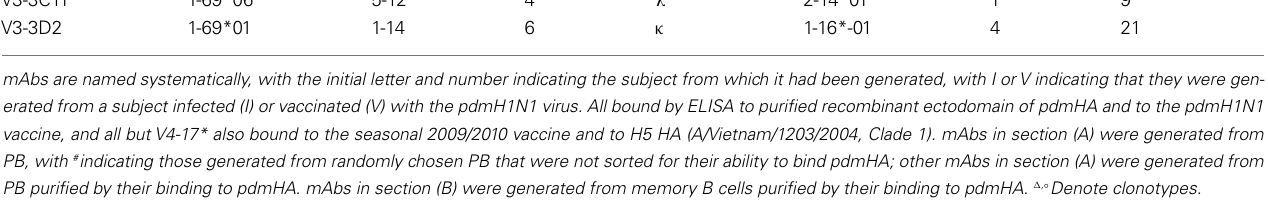
( Figure 3 ; Table 1 ) and all bound to the purified ectodomain of H5 HA of an H5N1 avian influenza virus A/Vietnam 1203/2004 (Clade 1; Table 1 ; Figure 3 ). The binding of the anti-HA stem mAbs to the seasonal influenza and pdmH1N1 vaccine was com- parable to the binding of the anti-HA head mAbs (e.g., binding of V2-36 to the seasonal influenza and pdmH1N1 vaccine and binding of V4-17 to the pdmH1N1 vaccine, Figure 3 ). Thus, the two conventionally manufactured vaccines were a good source of the conserved epitopes on the HA stem and thus the failure of the seasonal influenza vaccine to induce protective levels of hetero- subtypic anti-HA stem antibodies (Wrammert et al., 2008; Corti et al., 2010) was not due to the lack of the conserved epitopes in the